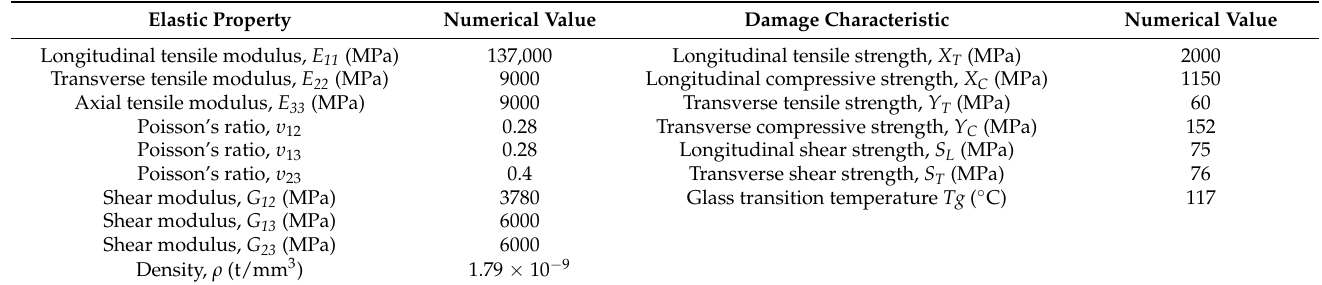
Table 2. Mechanical properties of CFRP at room temperature.